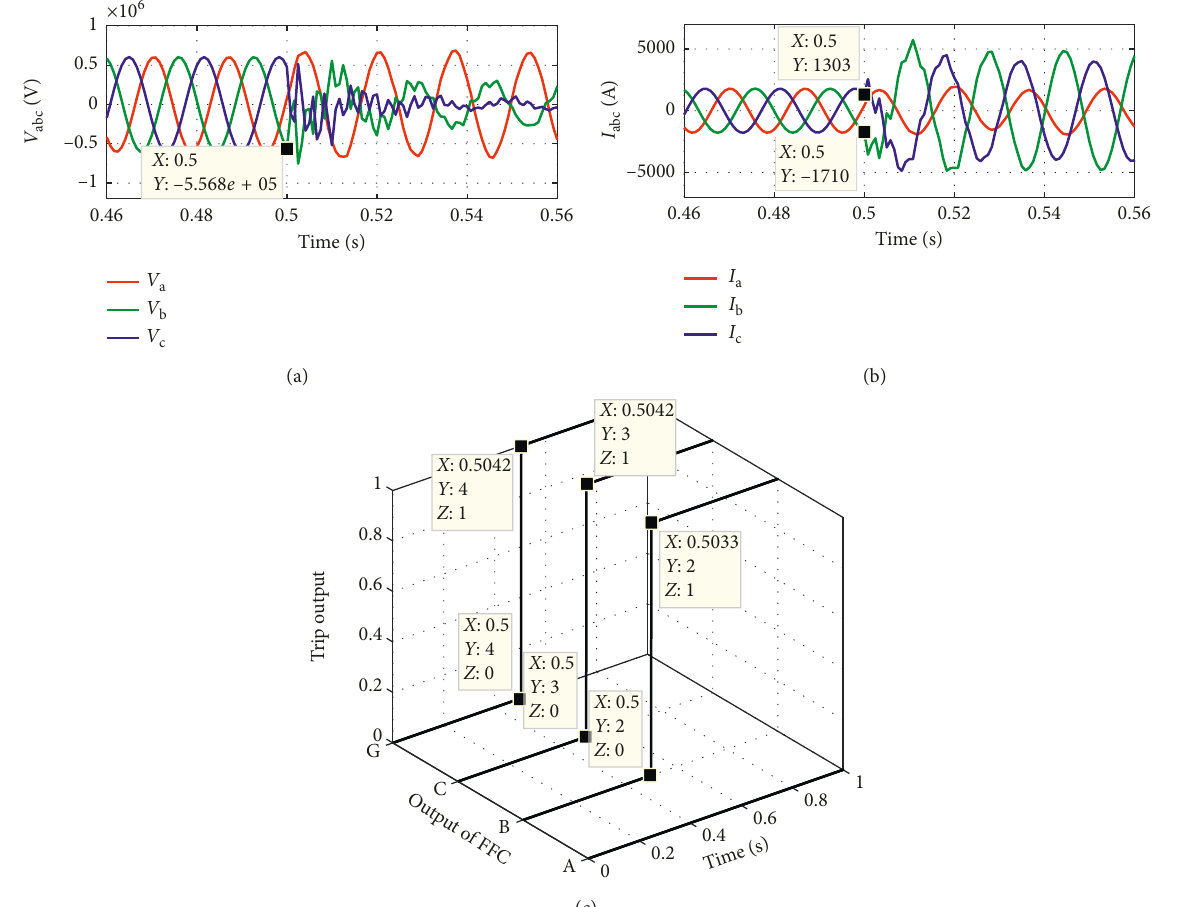
Figure 9: Performance during BCG fault at 165km, FIA waveform; (c) output of Table 10: Simulation results for the wide variations in system frequencies (FIA Simulated system data